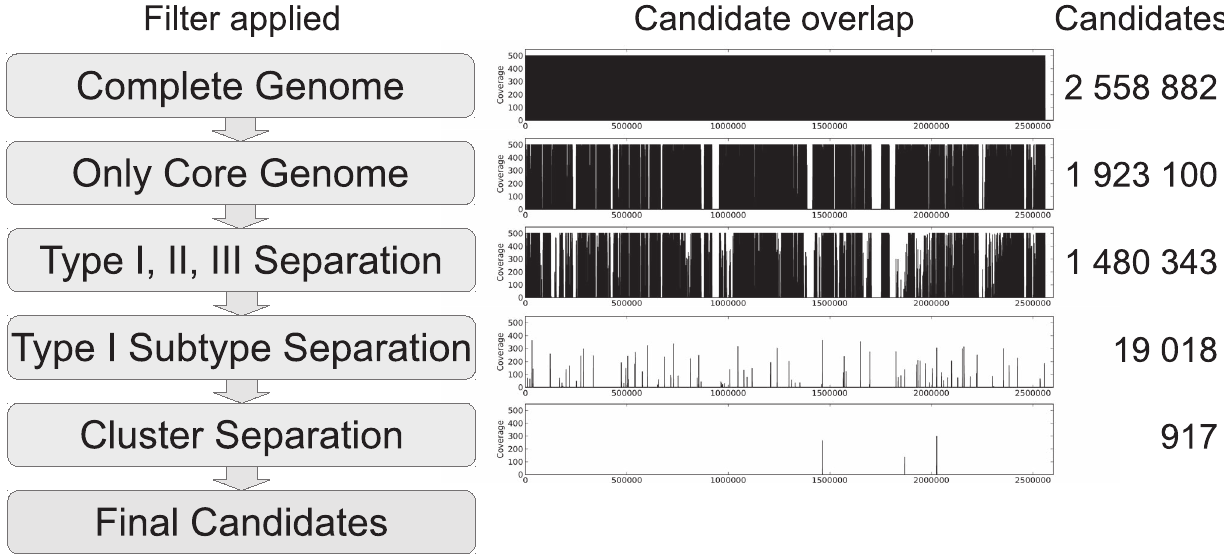
Figure 2. Strategy for the identification of SLST candidates in P.acnes . The first column shows the applied filter. The second column indicates the location of the remaining candidate fragments across the genome. The third column gives the number of remaining candidates. unidirectionally from the forward primer end on a 454 Genome Sequencer FLX + platform at GATC Biotech AG (Konstanz, Germany).